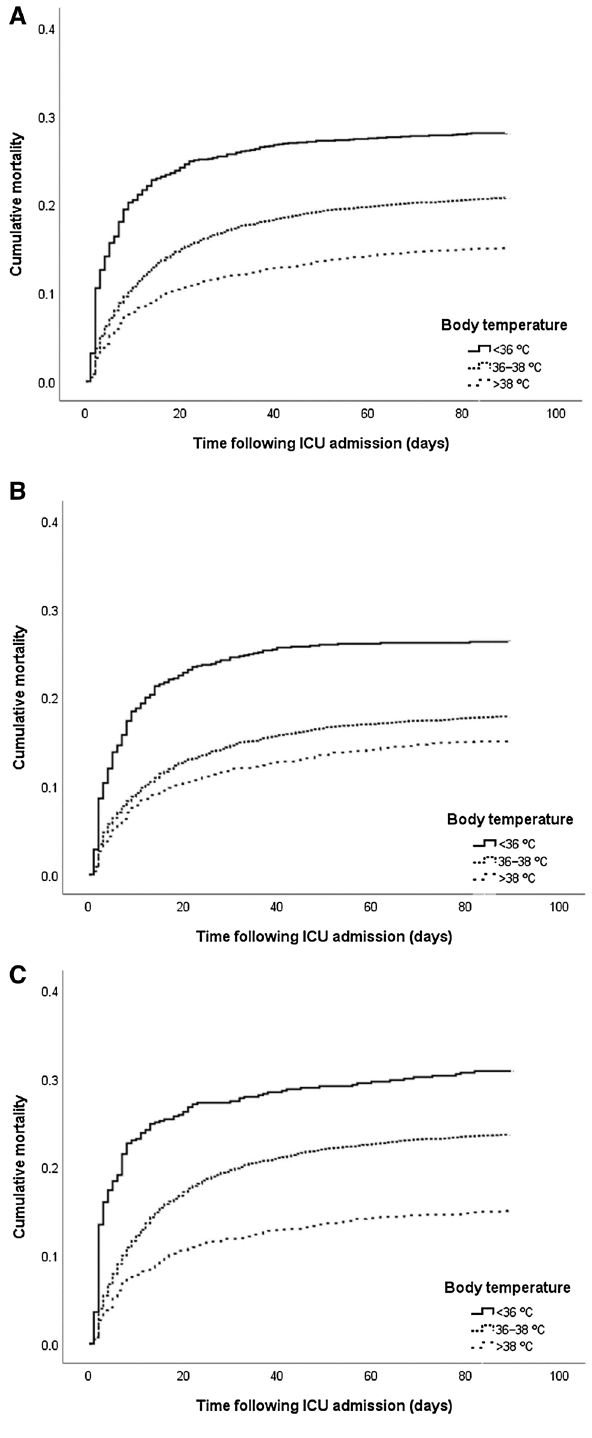
Figure 2. Probability of cumulative mortality according to the body temperature category in sepsis. ( A ) Overall patients (Log-rank p < 0.001). ( B ) Patients aged < 75 years (Log-rank p < 0.001). ( C ) Patients aged ≥ 75 years (Log-rank p <